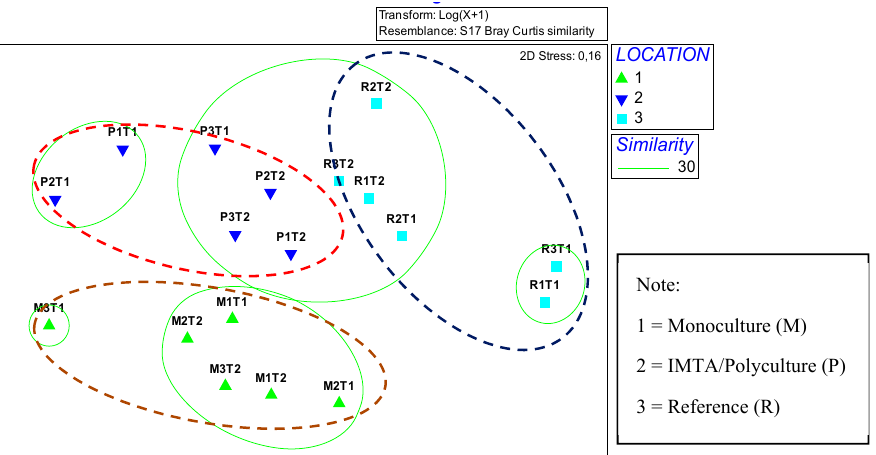
Figure 3. The 2D ordination of nonmetric multidimensional scaling (NMDS), indicating three groups based on sampling locations with 30% similarity values (green circle). Note: red, dashed circle: tendency of grouping / clustering at the stations of the IMTA site; brown, dashed circle: tendency of grouping / clustering at the stations of the monoculture site; blue, dashed circle: tendency of grouping / clustering at the stations of the reference site.